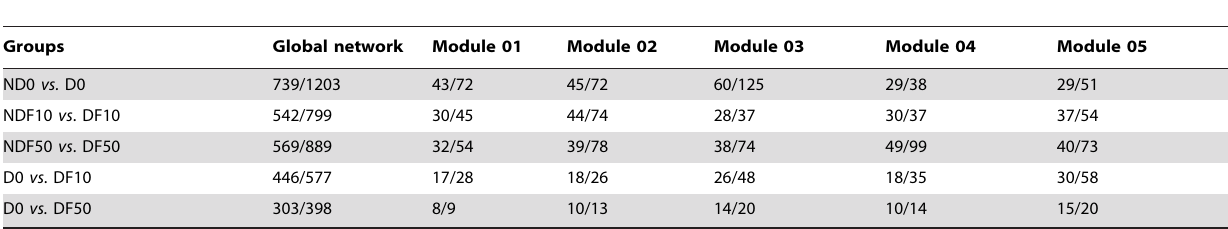
Table 1. Values of nodes/edges for each comparison considering the global network and the subnetworks